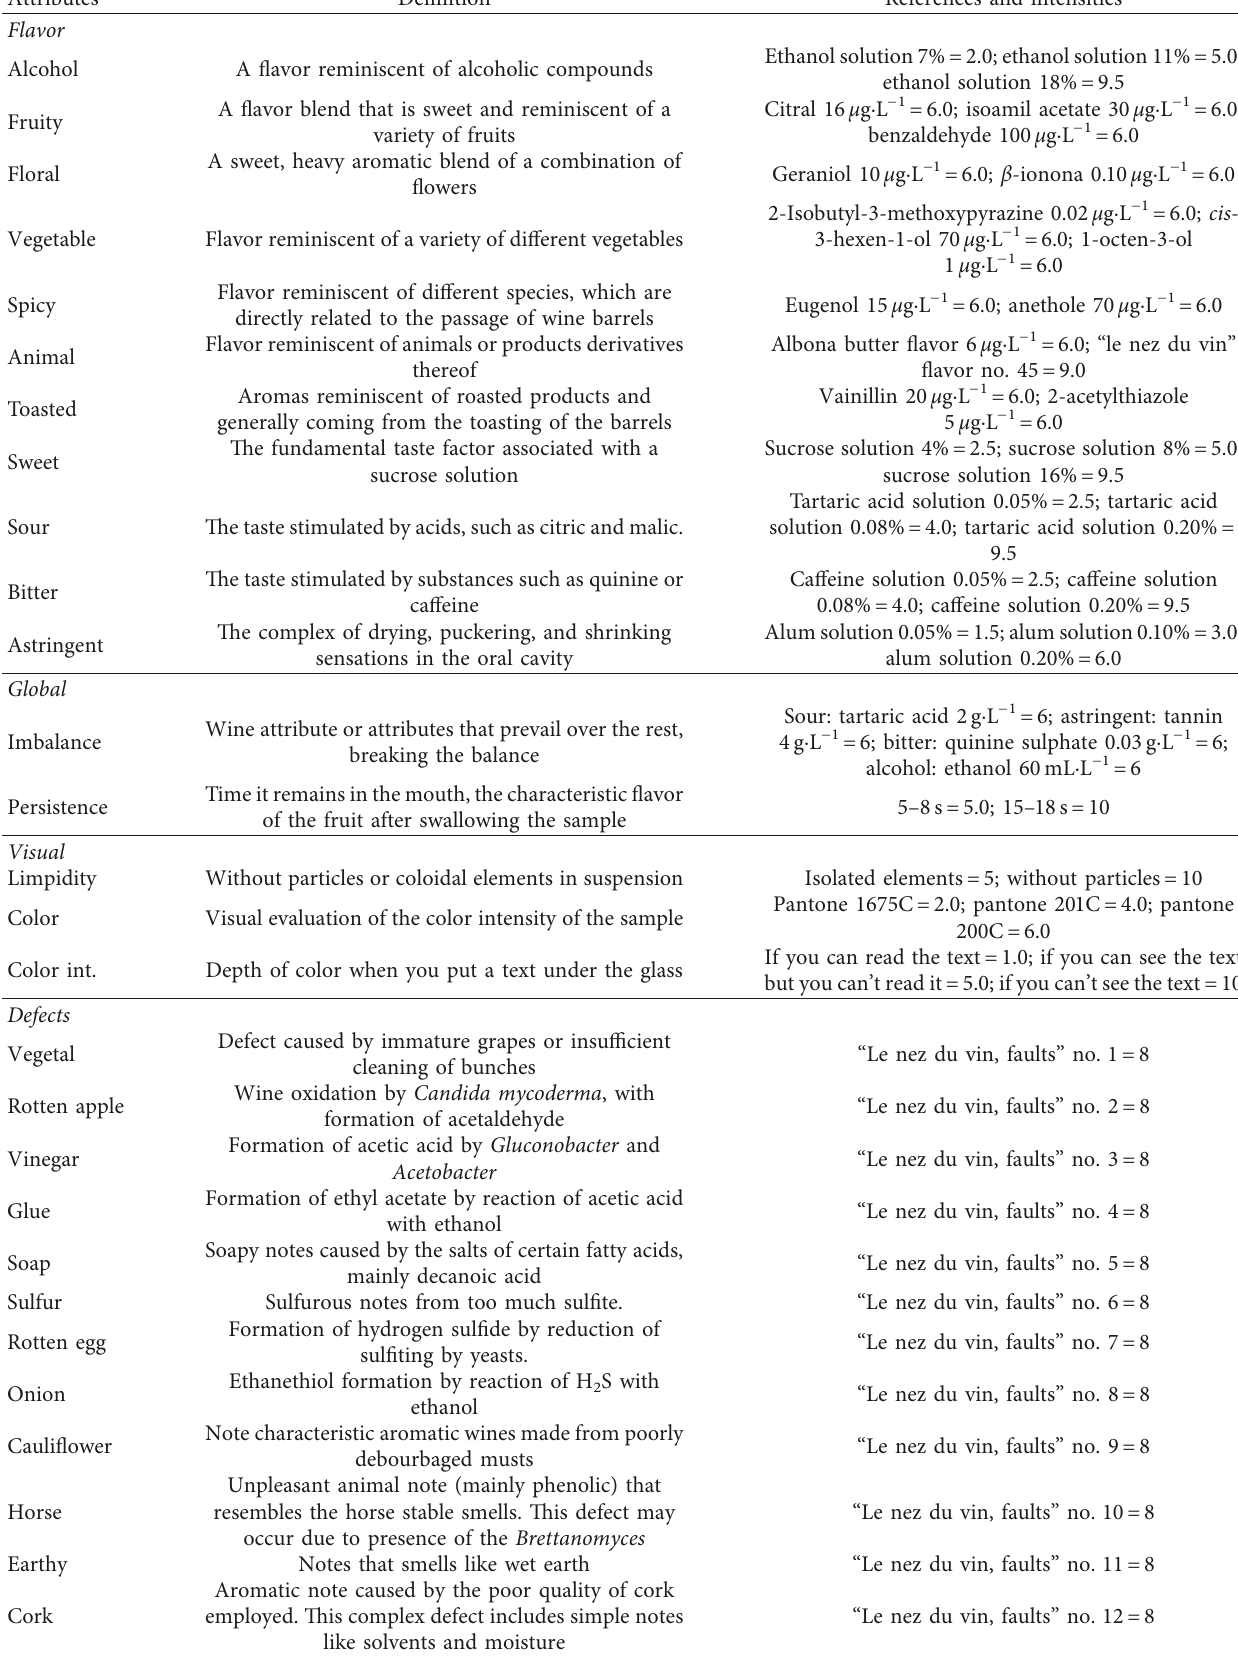
Table 3: Lexicon used for the descriptive analysis of Fondill´on